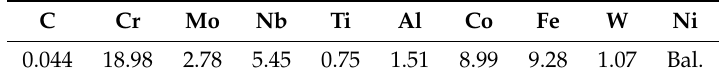
Table 1. Chemical composition of the 718Plus alloy used in this study (in